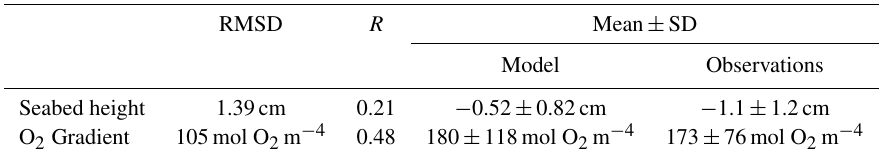
Table 5. Statistics for model–observation comparison, including the root mean square difference (RMSD) and the correlation coefficient ( R ). The mean and standard deviation of estimates from both the model and observations are also